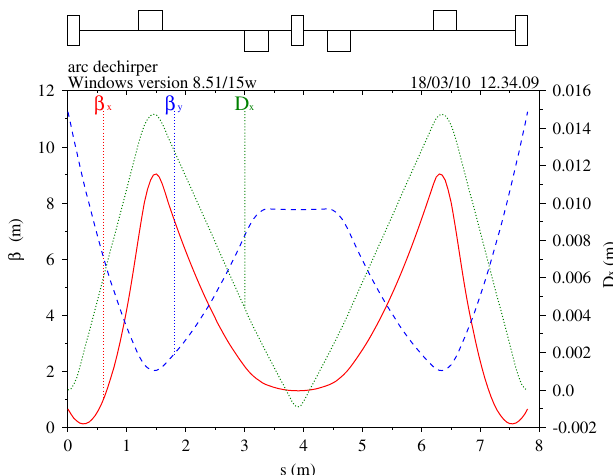
FIG. 7. Lattice functions for an isochronous achromatic de- chirping arc that contains three short bending magnets.